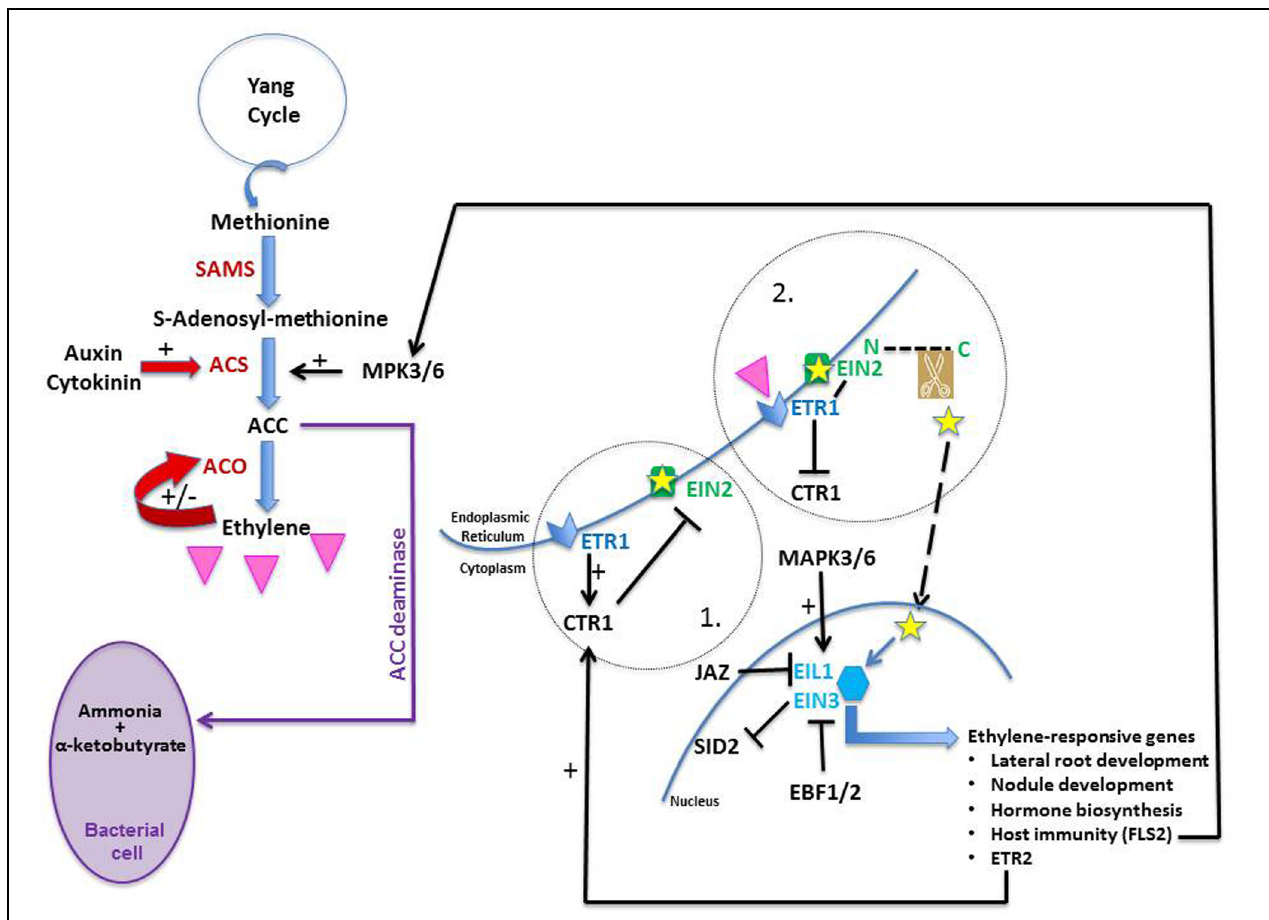
FIGURE 3 | Ethylene biosynthesis and transduction pathway. Methionine is the precursor of ethylene (pink triangle). It is converted into S -adenosyl-methionine (SAM) by SAM synthetase (SAMS); SAM is converted into 1-aminocyclopropane-1-carboxylate (ACC) by ACC synthase (ACS). ACC is later converted into ethylene by ACC oxidase (ACO). Both auxin and cytokinin are known to promote ethylene production; the former up-regulates ACS expression whereas the latter prevents ACS degradation. Ethylene is known to modulate its own levels by stimulating ( + ) or inhibiting ( − ) ACO activity. ACC deaminase is an enzyme found in certain types of bacteria; it converts ACC into ammonia and α -ketobutyrate and both may be used as nutrients by the bacteria. When no ethylene is sensed in a cell (circle 1), ethylene receptors (such as ETR1) located on the ER membrane promote CTR1 activity; in doing so, they allow CTR1 to phosphorylate EIN2 which inactivates it. Upon ethylene perception (circle 2), ETR1 is dephosphorylated and CTR1 is switched off. ETR1 can now bind efficiently to EIN2 which is activated. Its C-end terminus (small yellow star) is cleaved and moves to the nucleus where it stabilizes the transcription factors EIN3 and EIL1, which are then able as dimers to trigger the expression of ethylene-responsive genes, inducing many developmental and biochemical events. When ethylene is not perceived, EIN3 and EIL1 are targeted to proteasomes via the action of EBF1/2. MAP kinases 3 and 6 (MAPK3/6) are known to activate ACS enzymes and to phosphorylate EIN3 in Arabidopsis , protecting it from degradation. Jasmonic acid is known to work synergistically with ethylene by promoting the degradation of JAZ2, a protein known to repress EIN3/EIL1. Finally, EIN3/EIL1 inhibits salicylic acid synthesis as they bind to the promoter of SID2, one of its biosynthetic genes, thus inactivating